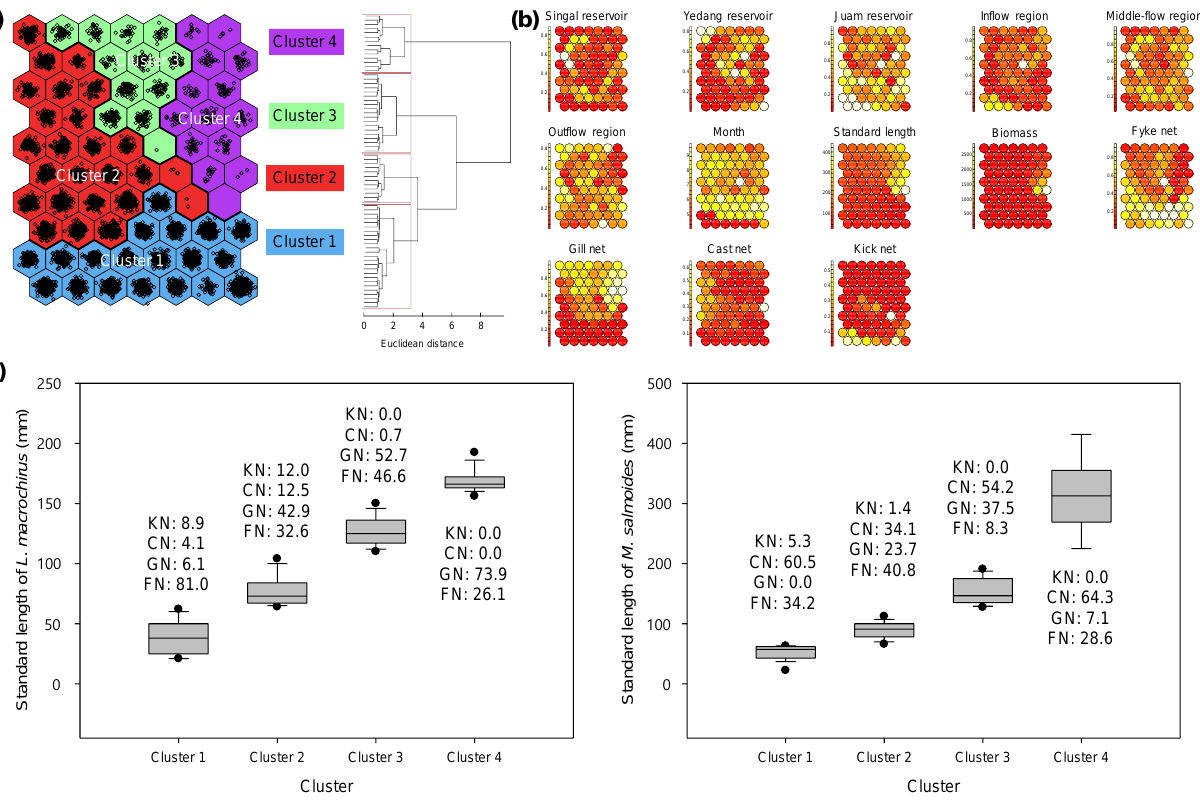
Figure 4. ( a ) Fishes sampled in the SG, YD, and JA were assigned to 70 self-organizing map (SOM) output neurons arranged into a two-dimensional grid (10 × 7). The neurons were grouped into four clusters with hierarchical cluster analysis and U-matrix values; ( b ) Component planes display the contribution of each variable to the classification of sampling sites, gears, and the standard length and biomass of fish. White neurons represent high values of each variable, whereas red neurons are for low values. The values were calculated during the learning process of the network; ( c ) A standard length distribution of dominant species ( Lepomis macrochirus and Micropterus salmoides ) by each cluster. The numbers indicate the percentage of fish caught by the sampling gear.